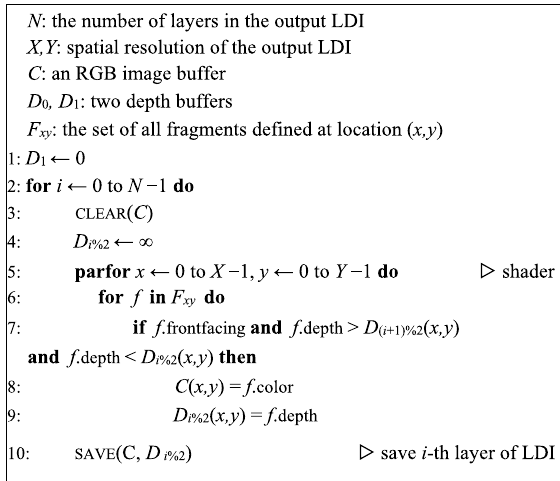
Algorithm 1 Depth peeling for LDI rendering .